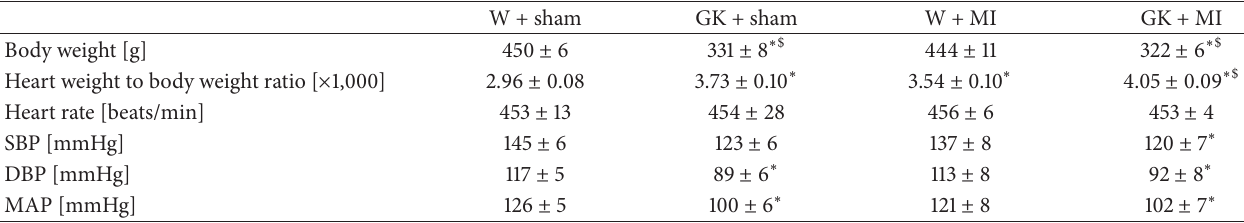
Table 1: Biochemical parameters in Goto-Kakizaki (GK) and control rats 24 h after sham operation or myocardial infarction. W + sham GK + sham W + MI GK + MI Plasma glucose [mmol/L] 8.5 ± 0.4 Plasma triglycerides [mg/dL] 67 ± 9 60 ± 9 67 ± 7 88 ± 8 Plasma cholesterol [mg/dL] 70 ± 8 93 ± 6 71 ± 7 91 ± 7 Serum insulin [mU/L] 6.3 ± 0.8 Urine glucose [g/L] 0.13 ± 0.02